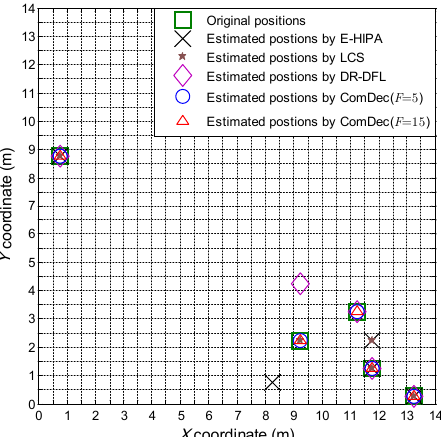
Figure 11. Comparison of the original target positions and the estimated target positions of different DFL approaches.